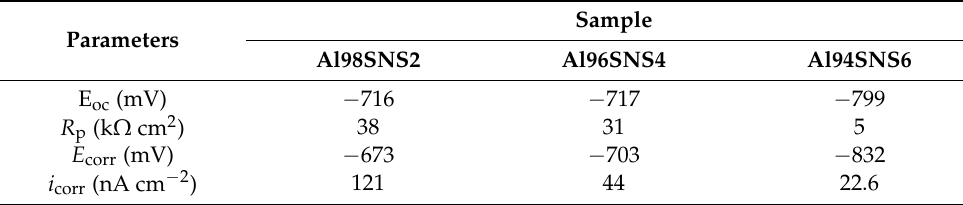
Table 7. Main corrosion parameters of the investigated